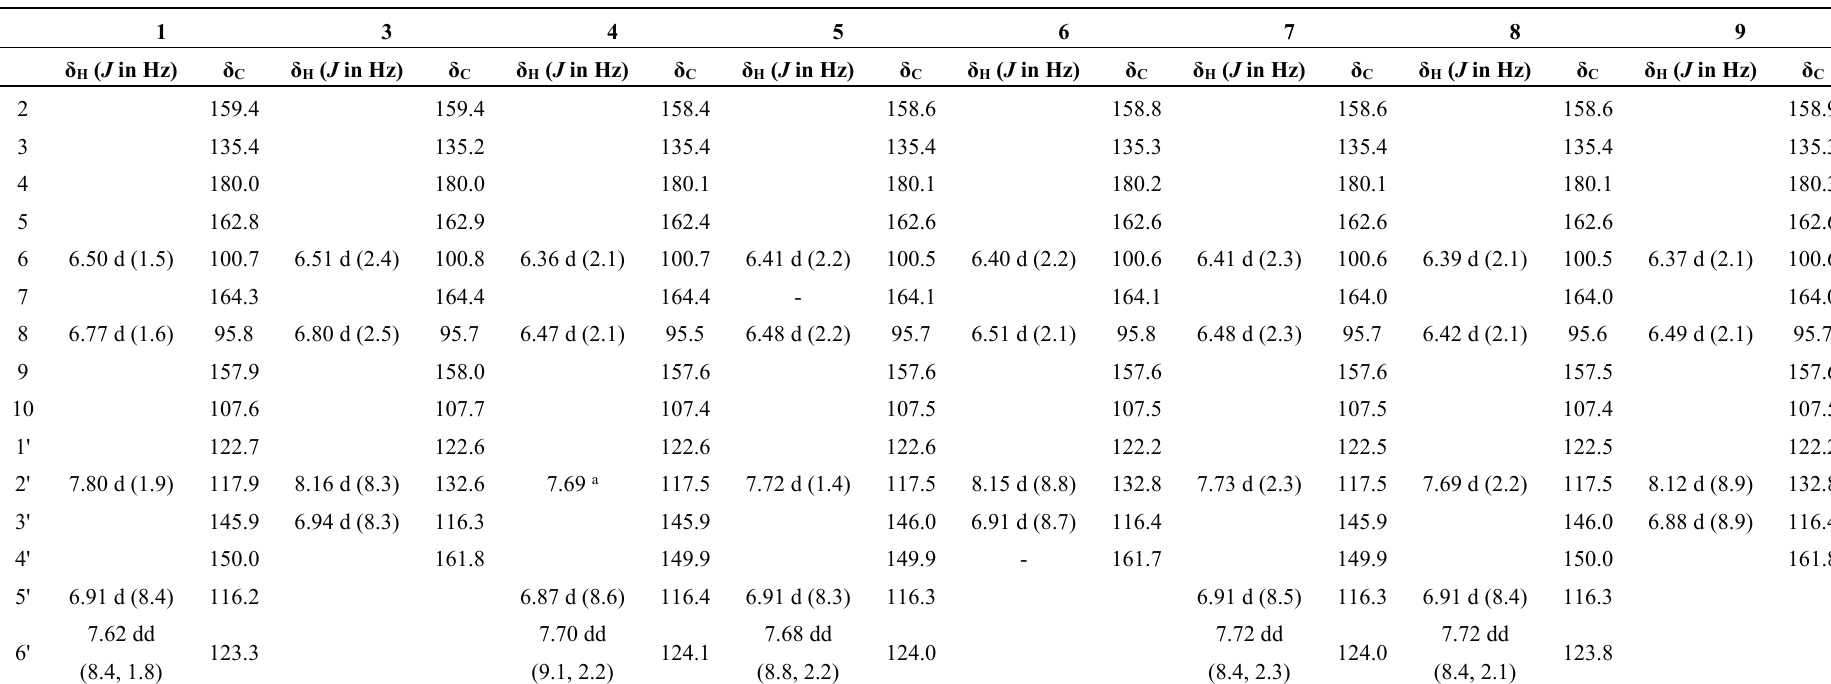
Table 1. NMR spectroscopic data (methanol- d 4 , 500 MHz) for the aglycones of compounds 1 , 3 – 15 , 17 and 18